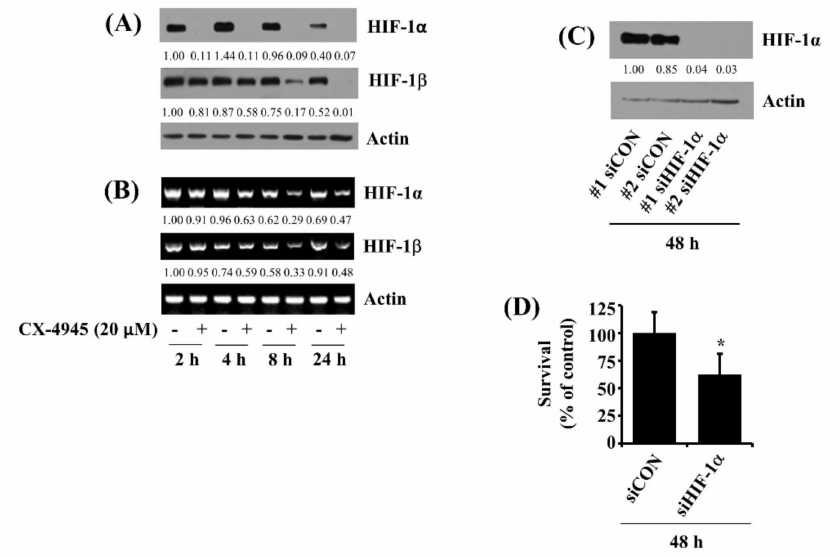
Figure 8. Effects of CX-4945 on the expression of HIF-1 α in HuCCT-1 cells. ( A ) HuCCT-1 cells were treated with CX-4945 (20 µ M) or vehicle control (DMSO) at indicated time point. At each time point, whole-cell lysates were prepared and analyzed for levels of HIF-1 α , HIF-1 β , or β -actin by Western blotting. ( B ) HuCCT-1 cells were treated with CX-4945 (20 µ M) or vehicle control (DMSO) at indicated time points. At each time point, total cellular RNA was abstracted and analyzed for levels of HIF-1 α , HIF-1 β , or β -actin by RT-PCR. ( C ) HuCCT-1 cells were transfected with 200 pM of control siRNA (siCon) or HIF-1 α siRNA (siHIF-1 α ) for 48 h. Whole-cell lysates were prepared and analyzed for HIF-1 α , HIF-1 β , or β -actin by Western Blotting. ( D ) HuCCT-1 cells were transfected with 200 pM of control siRNA (siCon) or HIF-1 α siRNA (siHIF-1 α ) for 48 h, followed by measurement of the number of surviving cells by cell count assay. The cell count assay was performed in triplicate. Data are means ± SE of three independent experiments. * p < 0.05 compared to the value of siCon or siHIF-1 α at the indicated